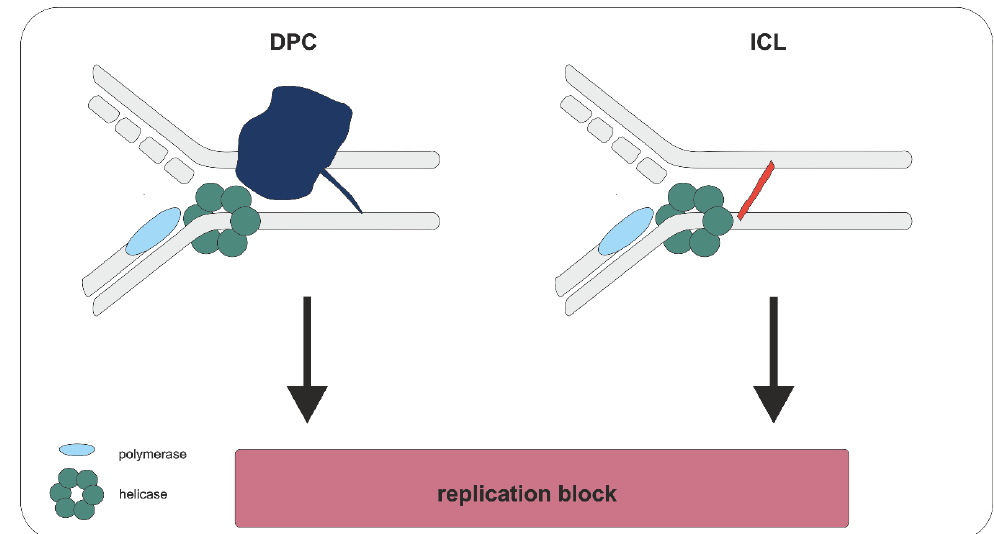
Figure 2. Blocking of replication by crosslinks. Crosslinks, like DPCs (blue) and ICLs (red) represent a physical obstacle for the replication machinery, including replication-associated key enzymes like helicases and polymerases. If left unrepaired, inhibition of replication compromises cell division and can consequently result in cell death.